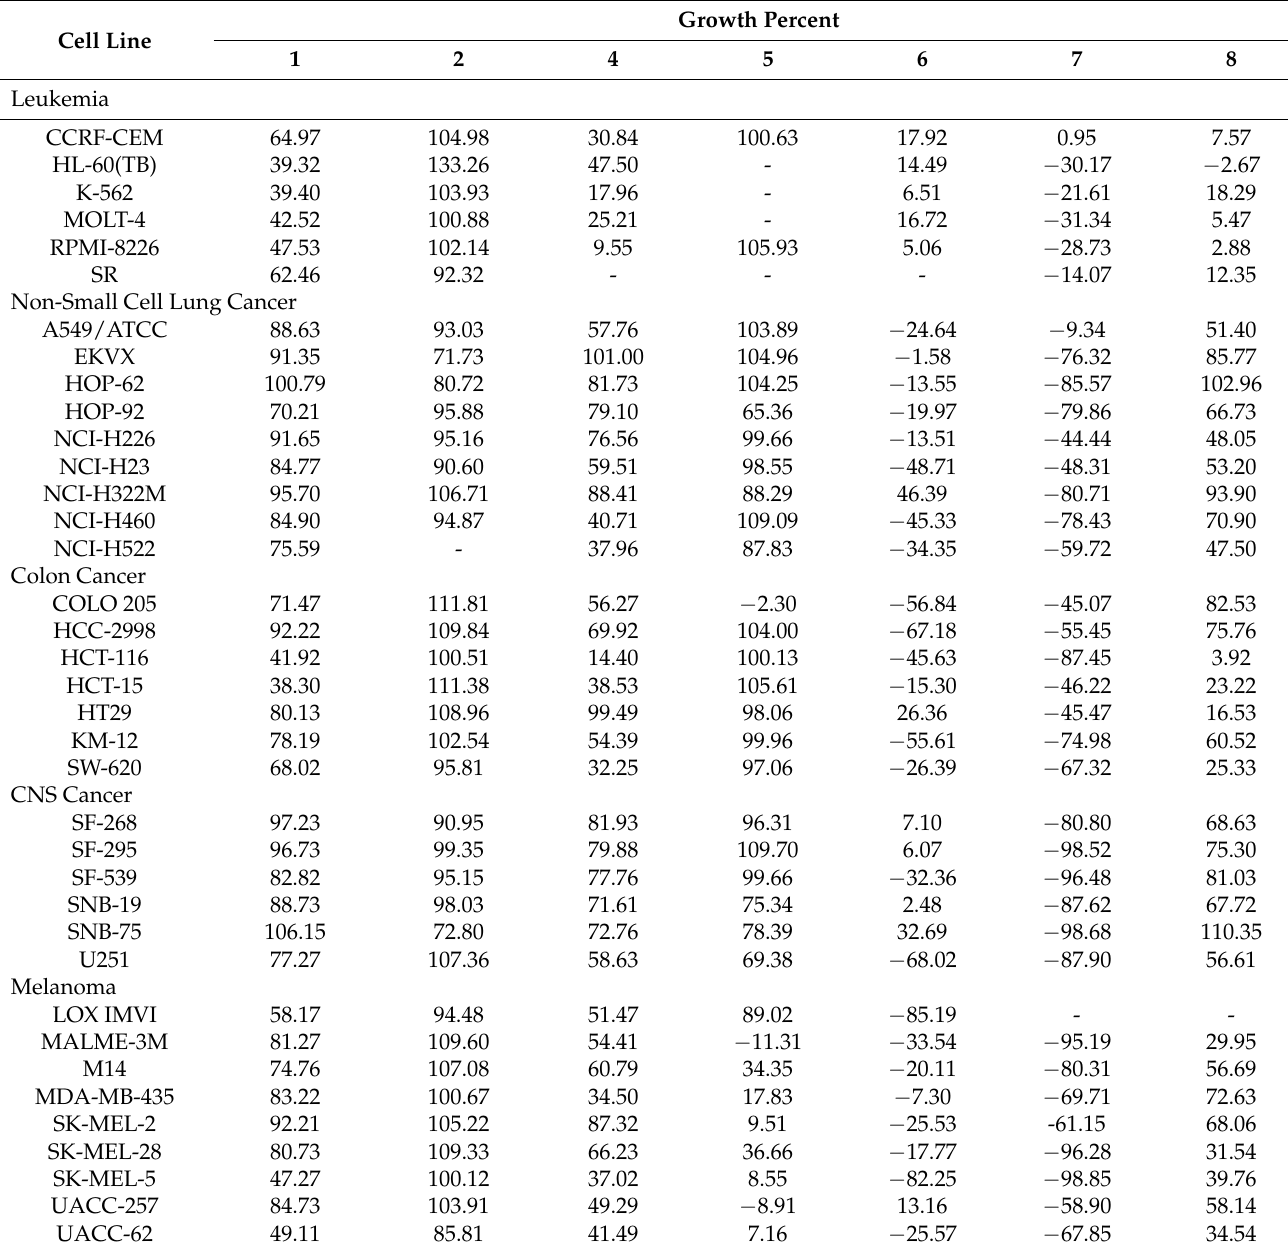
Table 1. In vitro antitumor activity of compounds 1, 2, 4 – 8 against human cancer cells of 60 lines at a concentration of 10 µ